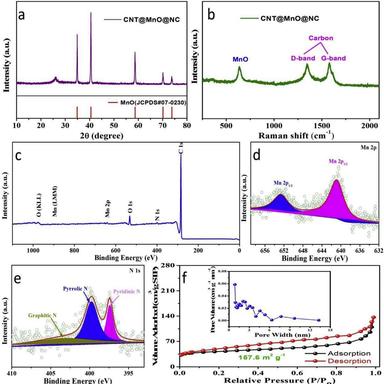
XRD pattern (a), Raman spectra (b) and XPS spectra of CNT@MnO@NC: (c) survey and high-resolution spectra of (d) Mn 2p and (e) N 1s. (f) N2 adsorption/desorption isotherms (Inset: correlating pore size distribution) of CNT@MnO@NC.